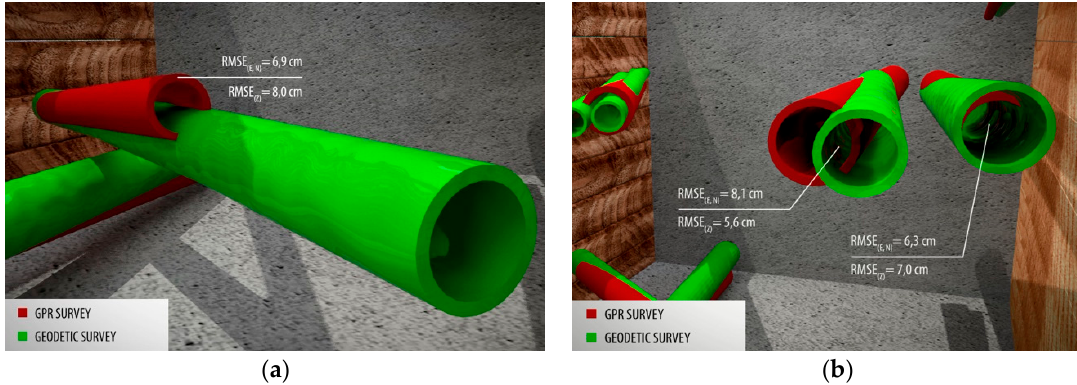
Figure 22. 𝑅𝑀𝑆𝐸 (cid:3043)(cid:3042)(cid:3046) and 𝑅𝑀𝑆𝐸 ∆(cid:3035) in the 3D space. ( a ) Water pipe No. 9; ( b ) cable duct No. 17 (left) Figure 22. RMSE pos and RMSE ∆ h in the 3D space. ( a ) Water pipe No. 9; ( b ) cable duct No. 17 (left) and and 13 (right) (see Table 1). 13 (right) (see Table